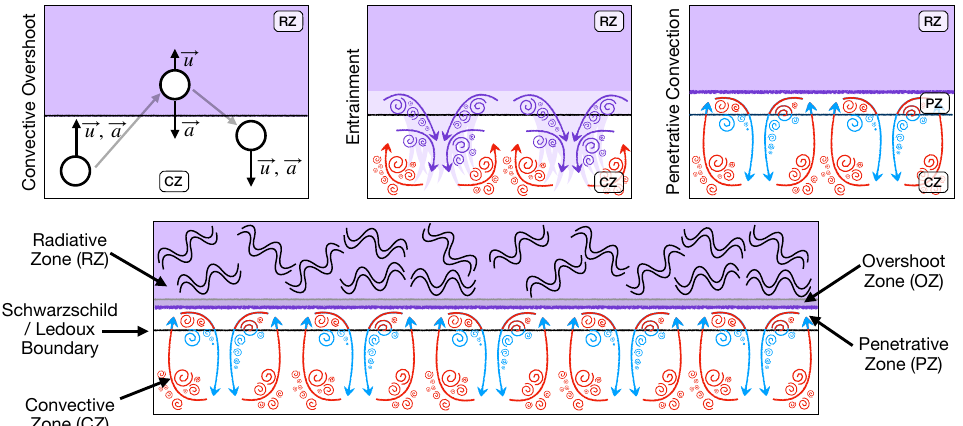
Figure 4. Three CBM processes are shown schematically in the top row. White fluid represents the well-mixed CZ, while purple fluid is the stable RZ. (Left) Convective overshoot (Section 3.2) occurs when a fluid parcel from the CZ crosses into the RZ; a positive entropy gradient in the RZ accelerates the parcel back toward the CZ. (Middle) Shear flows and overshooting motions drag RZ fluid into the CZ in a process called entrainment (Section 3.4). (Right) Convective penetration occurs when convection maintains a well-mixed region of fluid beyond the Schwarzschild boundary (Section 3.5). The bottom panel shows the structure of a statistically stationary convective boundary, which resembles the 1D “extended convective penetration” prescription (Section 2.6). This figure was originally published online under a CC BY license in Anders et al.